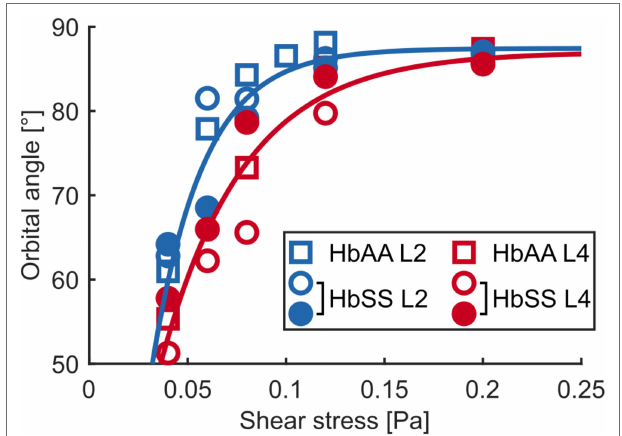
FIGURE 5 | The flip-flopping motion depends on density. Median orbital angle ϕ as a function of shear stress ηγ  0 for L2 and L4 layers of an HbAA sample and of two HbSS samples. The blue and red lines are visual guides for the behaviors of L2 (blue symbols) and L4 (red symbols) RBCs, respectively, regardless of healthy or SCD type.